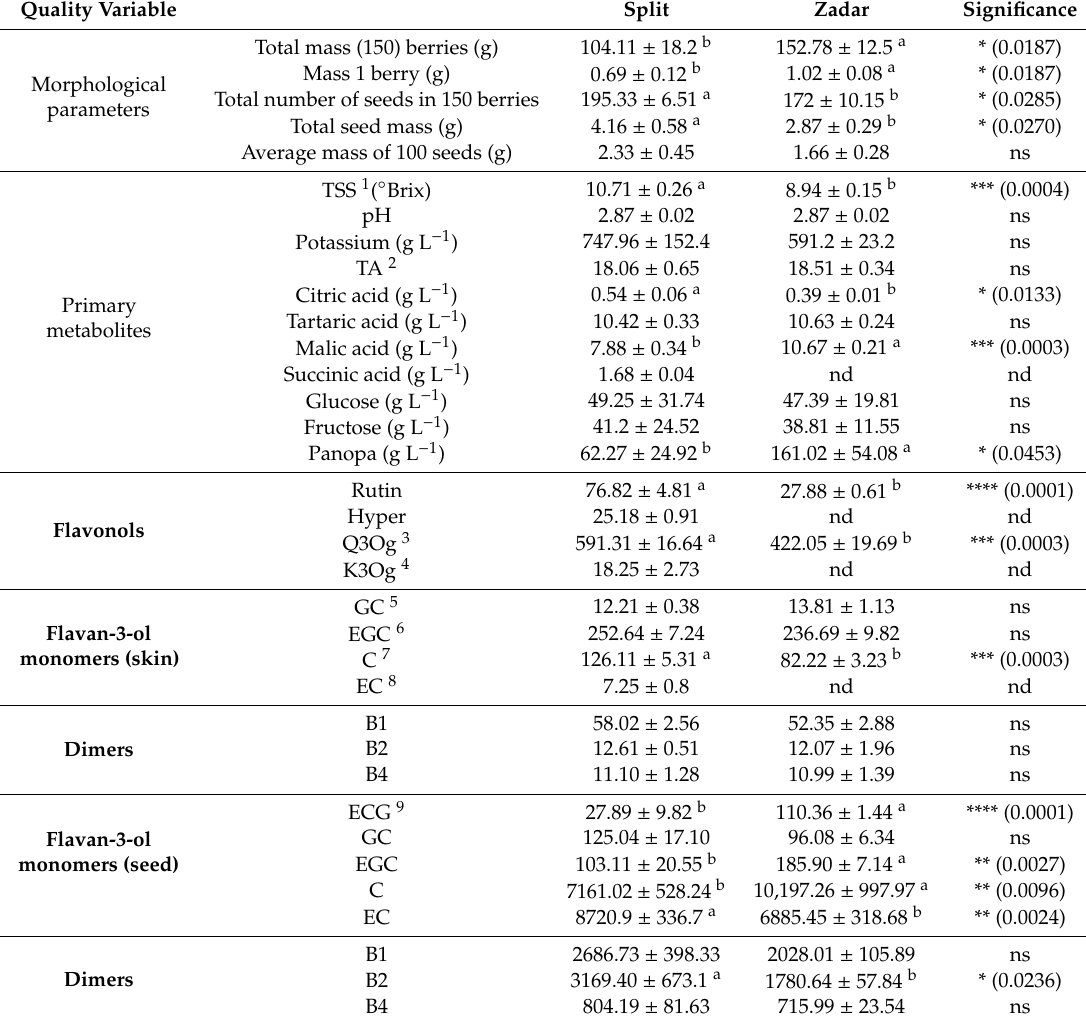
Table 4. Grape variables of green berries separated from H1 harvest date at Split and Zadar vineyards. Quality